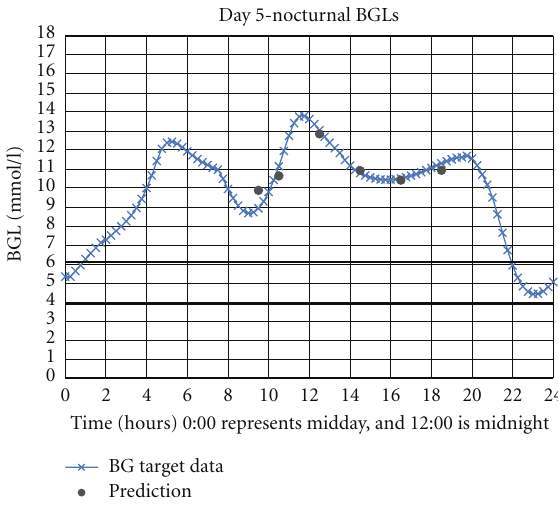
Figure 12: Predictions from trained ANNs on a test day which was not used during AIDA training. Each point represents a separate ANN, which was the best performing ANN over the 5 test days for a given prediction